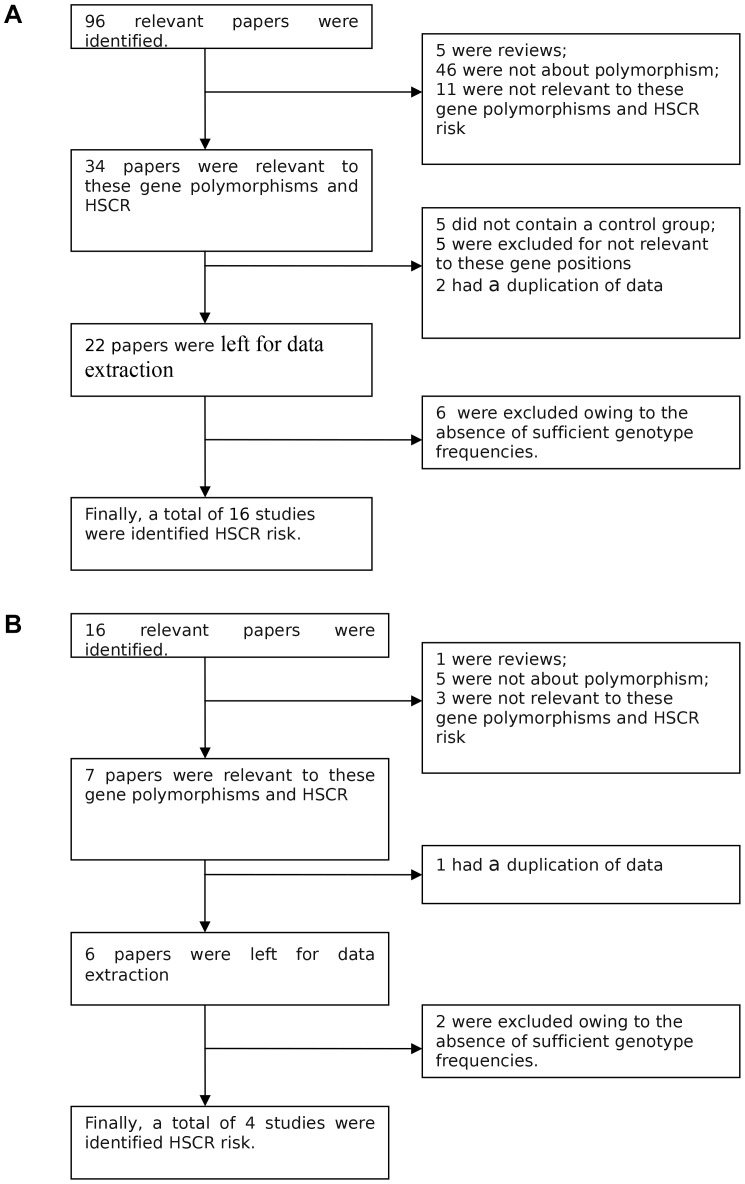
Process of selecting studies about RET and PHOX2B gene.